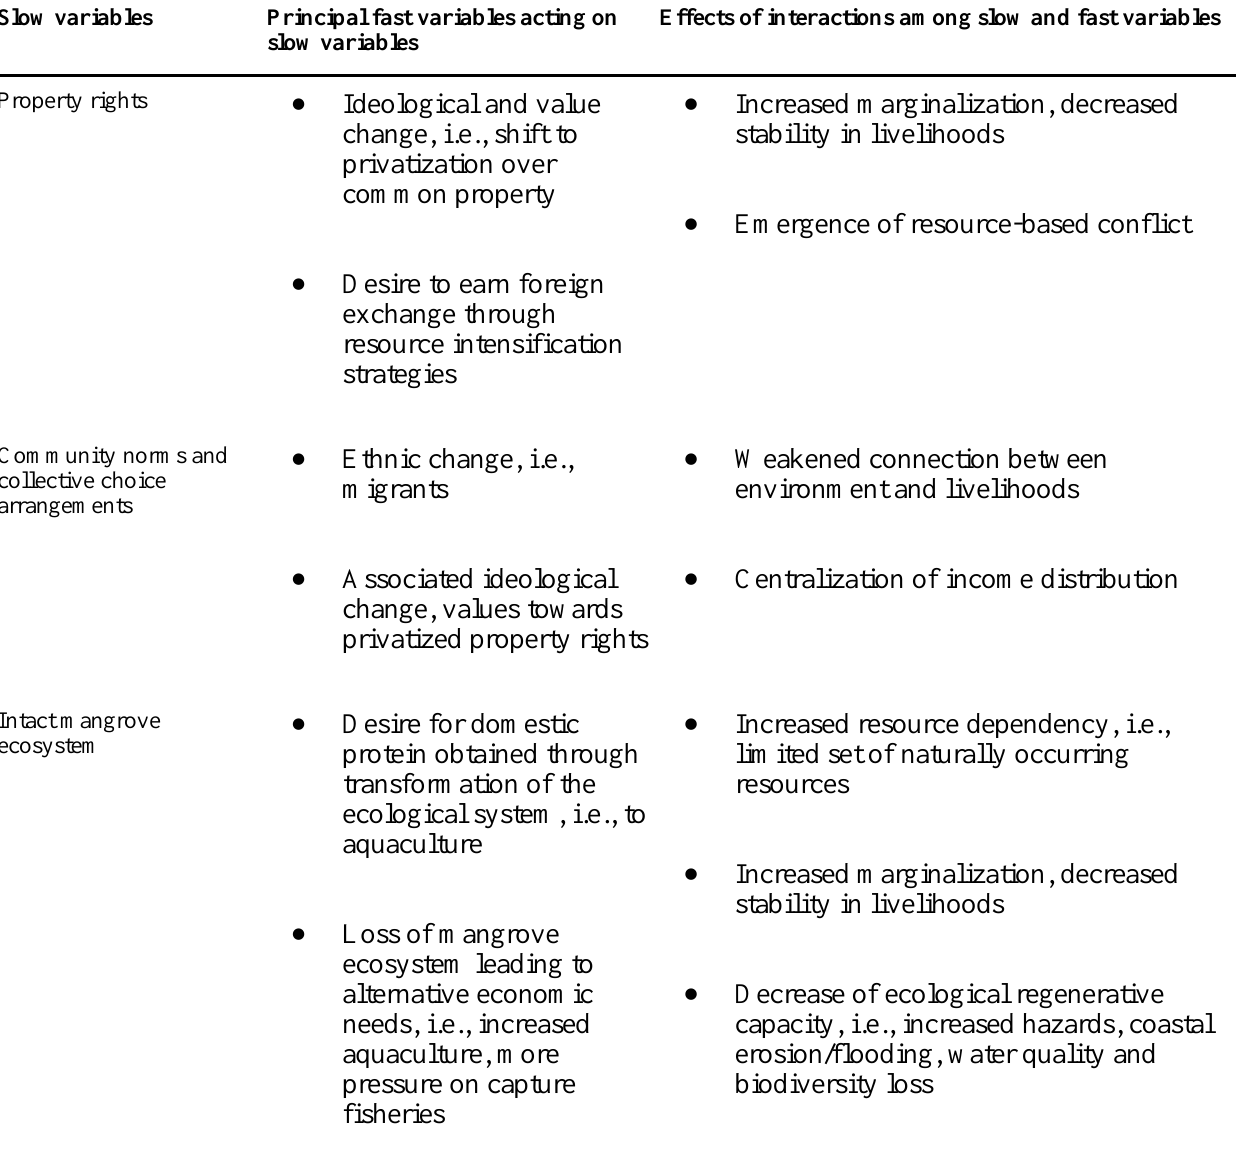
Table 2. Globalization and resilience in Banawa Selatan, Central Sulawesi. Slow variables Principal fast variables acting on Effects of interactions among slow and fast slow variables